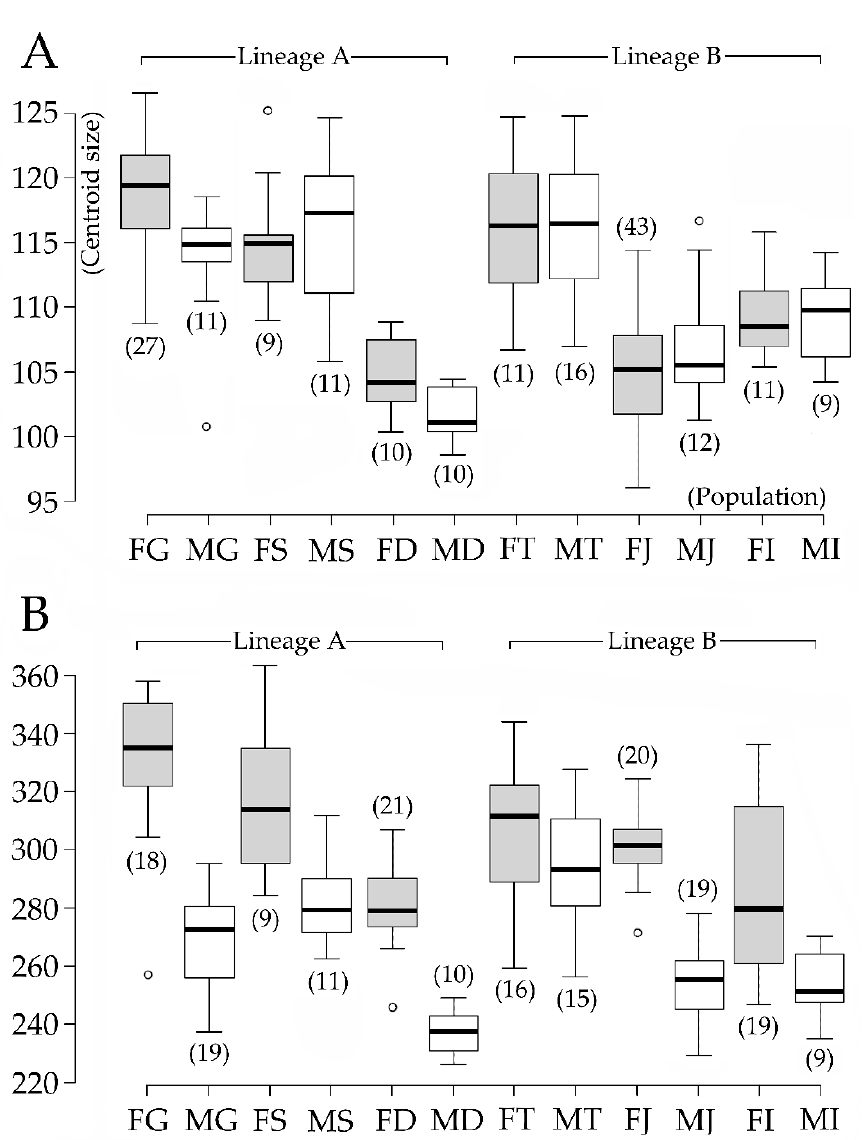
Figure 3. Box plot based on centroid size of sensilla distribution and pleonal points. ( A ) Box plot of sensilla distribution; ( B ) box plot of pleonal points. The numbers along the vertical axis indicate the centroid size. The initials along the horizontal axis indicate the group examined; FG: females Gazin, MG: males Gazin, FS: females Sokcho, MS: males Sokcho, FD: females Dongho, MD: males Dongho, FT: females Detan, MT: males Detan, FJ: female Jangsa, MJ: males Jangsa, FI: females Imrang, and MI: males Imrang. The numbers in parentheses indicate the numbers of individuals from each population. Center lines in the boxes show the medians, box limits indicate the 25th and 75th percentiles, whiskers extend 1.5 times the interquartile range from the 25th and 75th percentiles, and outliers are represented by dots.